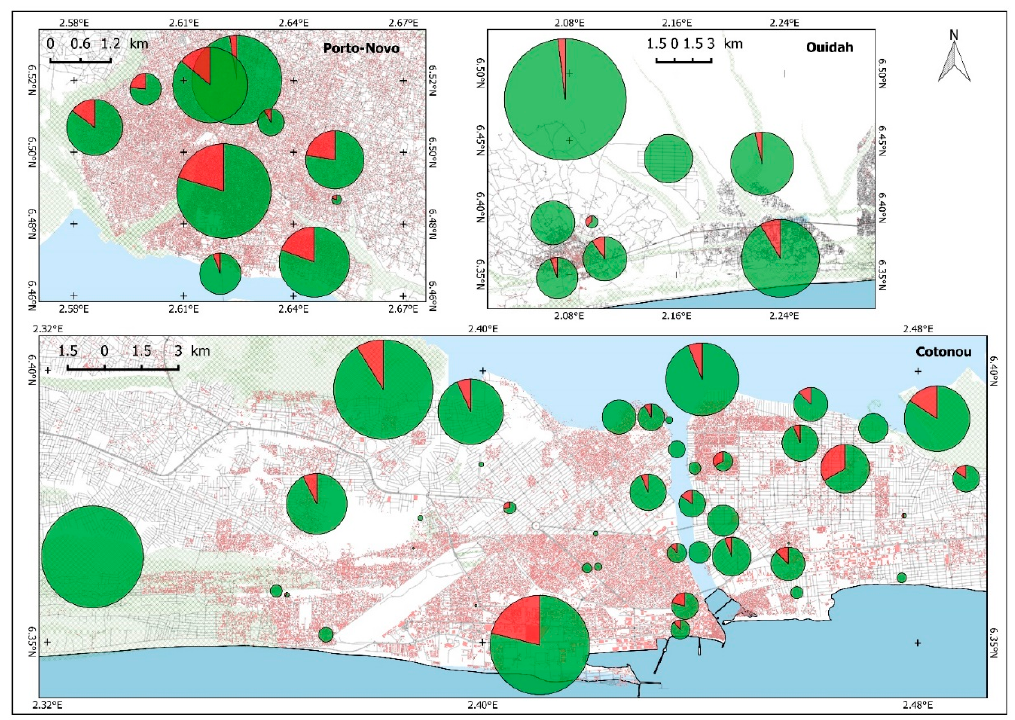
Figure 2. Sample size (green circles) and rodent-borne Leptospira prevalence (red pie charts) in the Porto-Novo, Ouidah, and Cotonou cities.